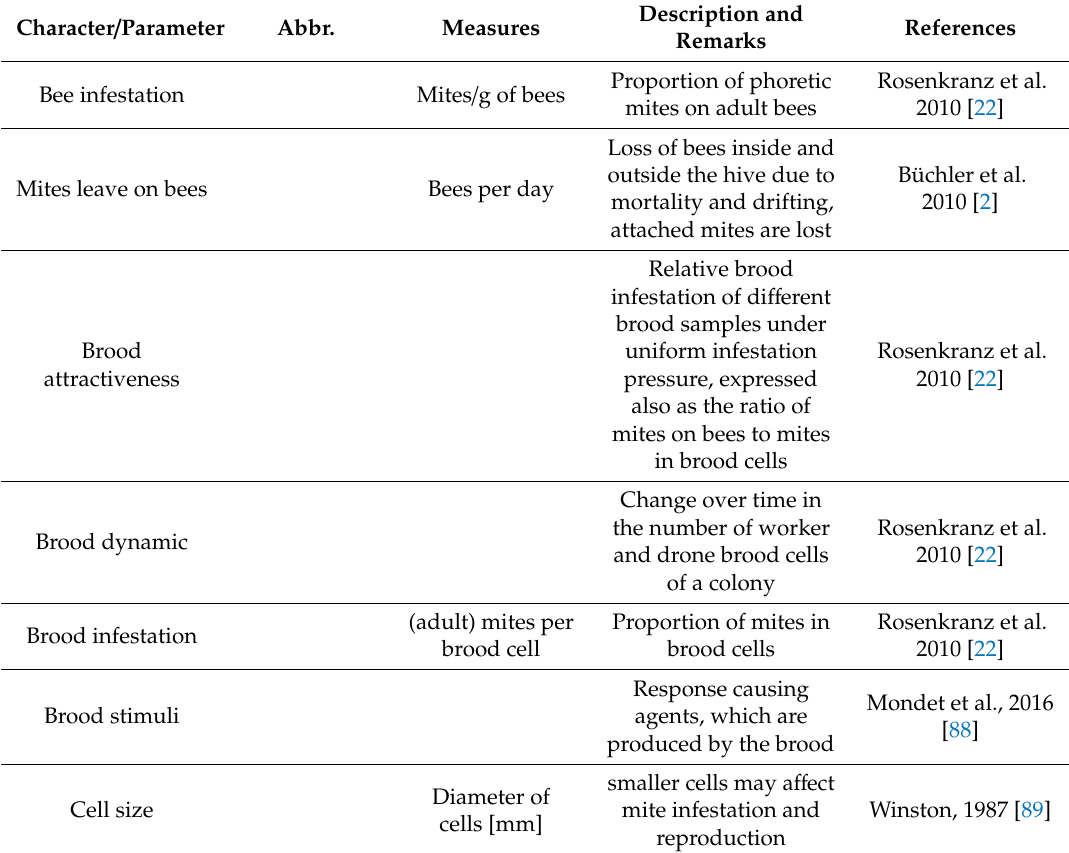
Table 1. Varroa resistance in honey bees—Definition of relevant characters and parameters. Character / Parameter Abbr.